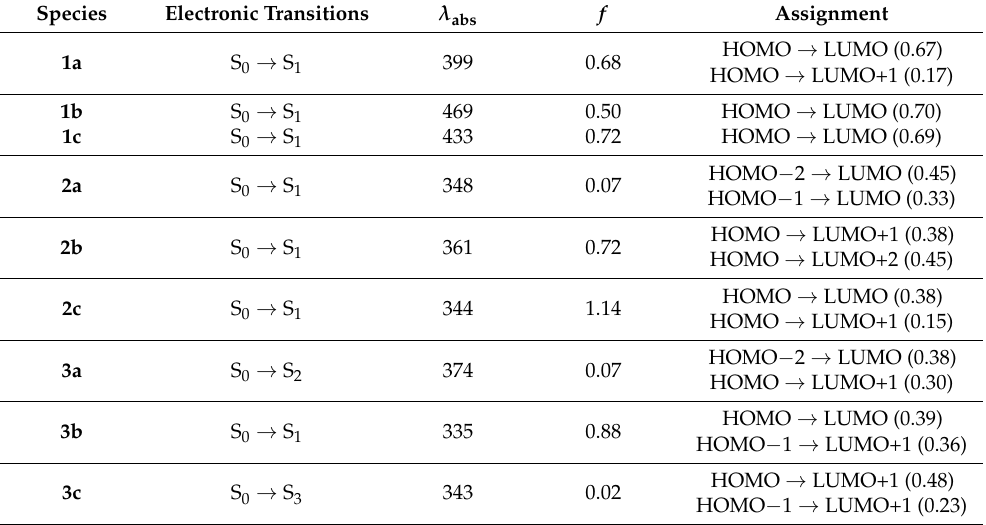
Table 2. The longest of absorption wavelengths λ abs , the oscillator strength f , and assignments for the designed molecules at the TD-PBE0/6-31G(d,p)//PBE0/6-31G(d,p) level. Species